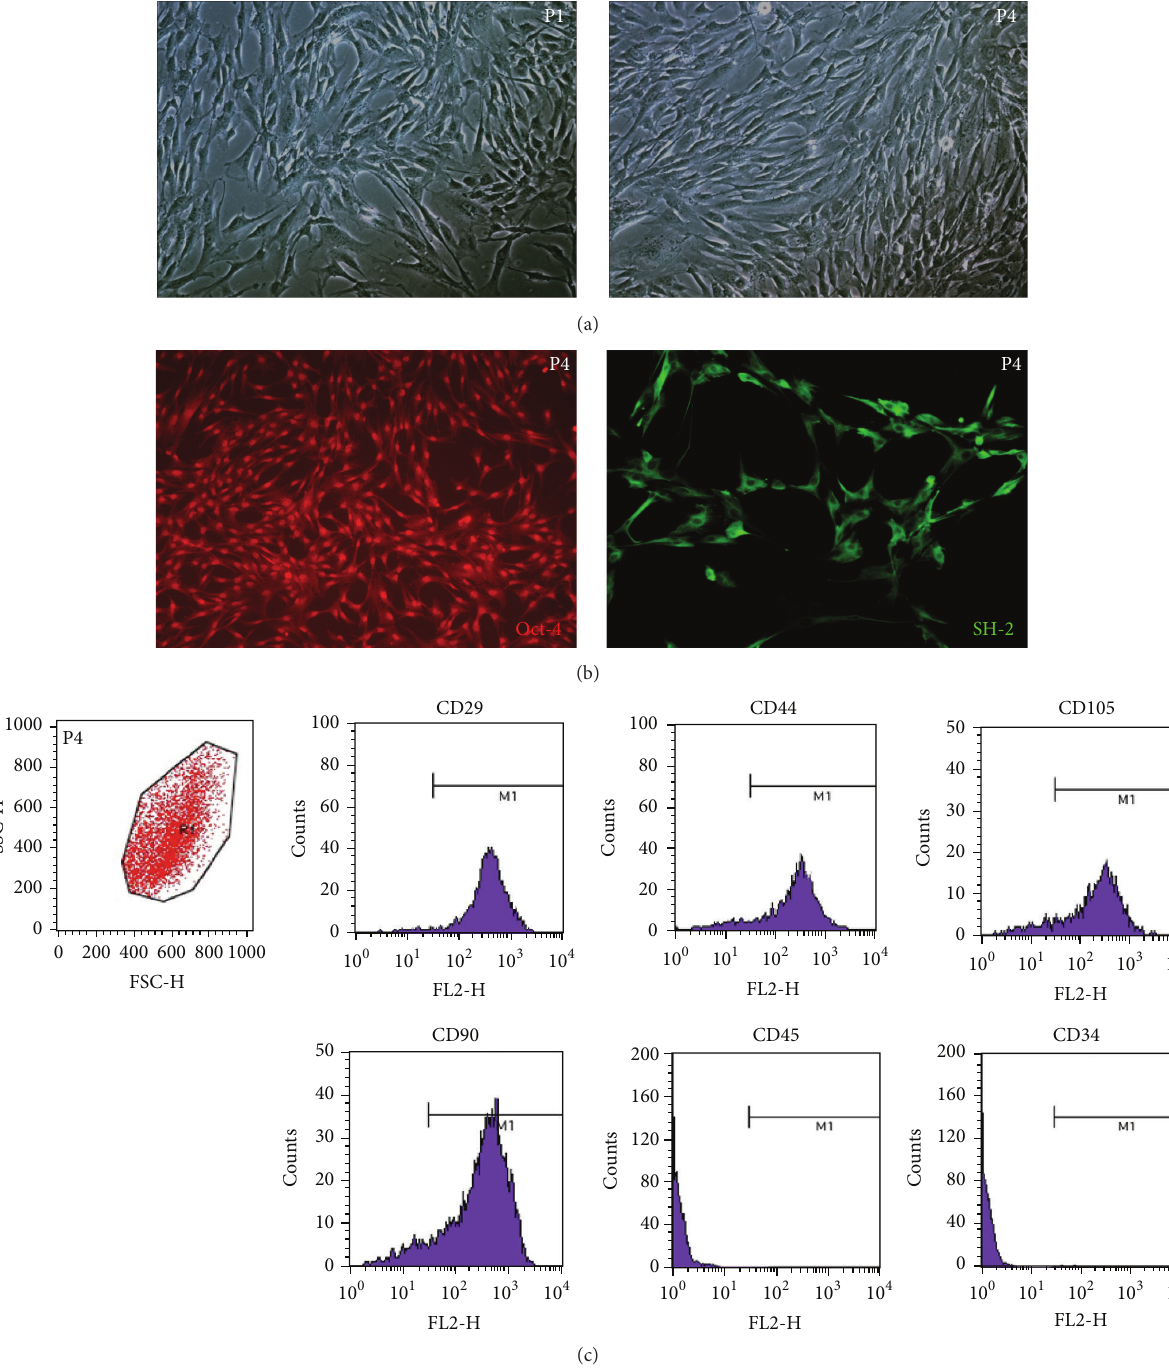
Figure 1: Morphology and molecular marker detection of isolated ADMSCs. (a) Phase-contrast micrographs of ADMSCs at P1 and P4. Most ADMSCs were spindle-shaped with scant cytoplasm and with granules around the nuclei (original magnification 100x). (b) Immunofluorescence detection: P4 ADMSCs were positive for Oct-4 and SH-2 (original magnification 100x). (c) FACS analysis: P4 ADMSCs were positive for CD29, CD44, CD105, and CD90 and negative for CD45 and